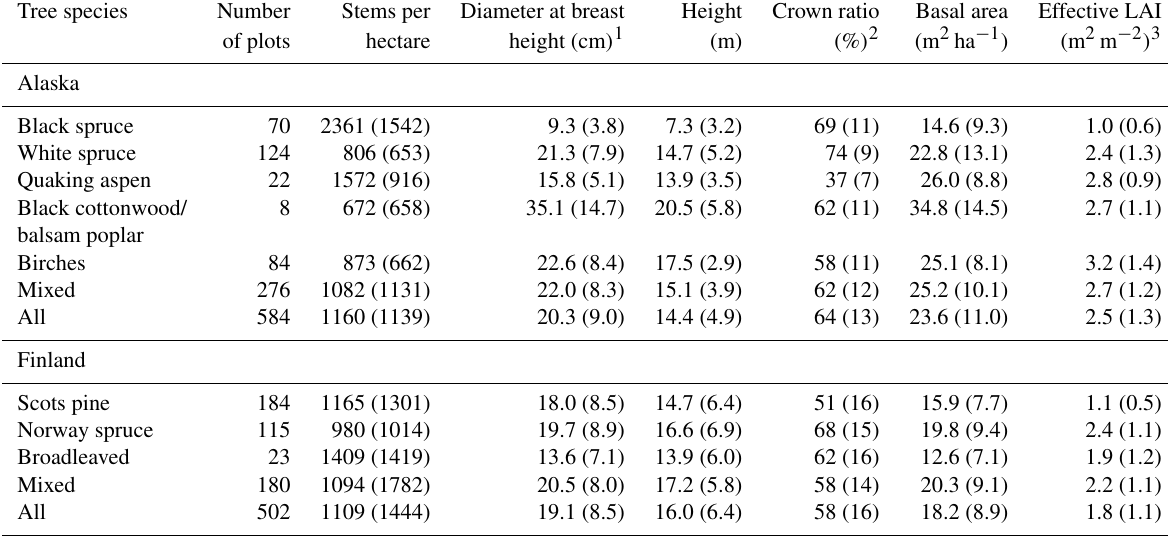
Table 1. Mean (standard deviation) of forest variables by dominant tree species in Alaska and Finland. The species dominance was deter- mined by basal area proportion: if the basal area of one of the species exceeded 80% of the total basal area, the plot was considered to be dominated by that species. The remaining plots were labeled as mixed.